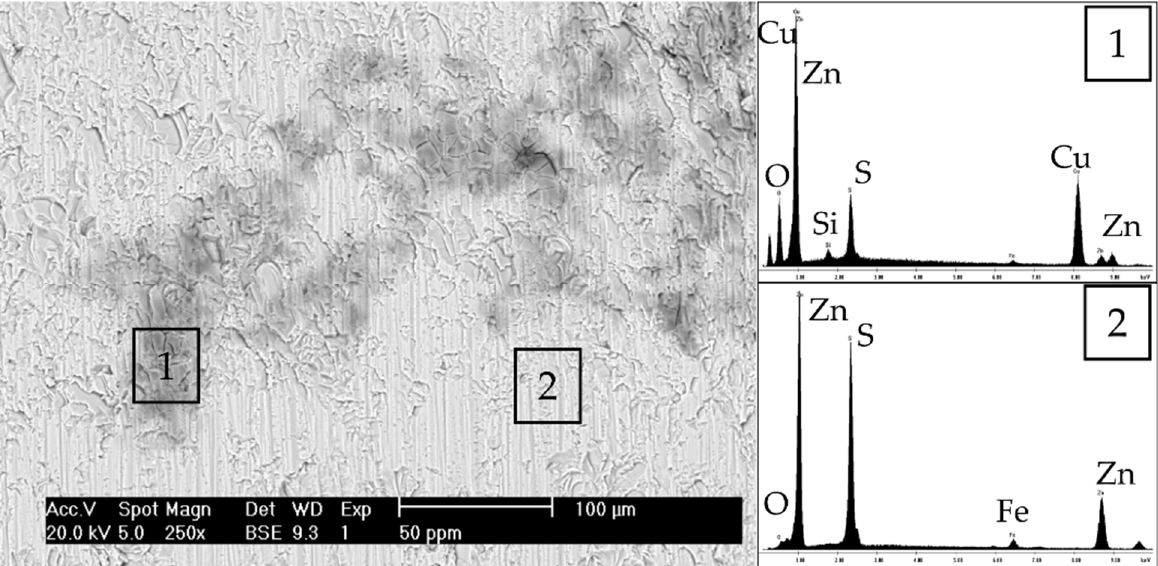
Figure 2. SEM micrograph and microprobe analysis showing Cu(OH) 2 adsorption/precipitation onto the sphalerite surface conditioned at pH 9 with 50 mg/L of Cu(II).